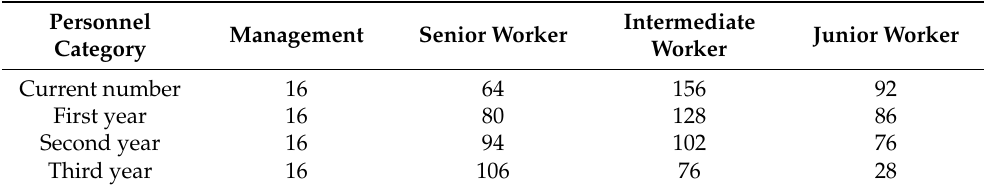
Table 6. Demand quantity of bridge and tunnel operation and maintenance units of operation and maintenance project of the Shuohuang Railway